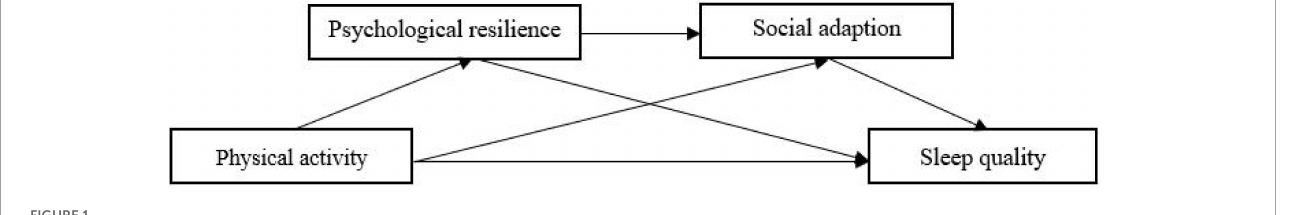
FIGURE1 Hypothetical model.